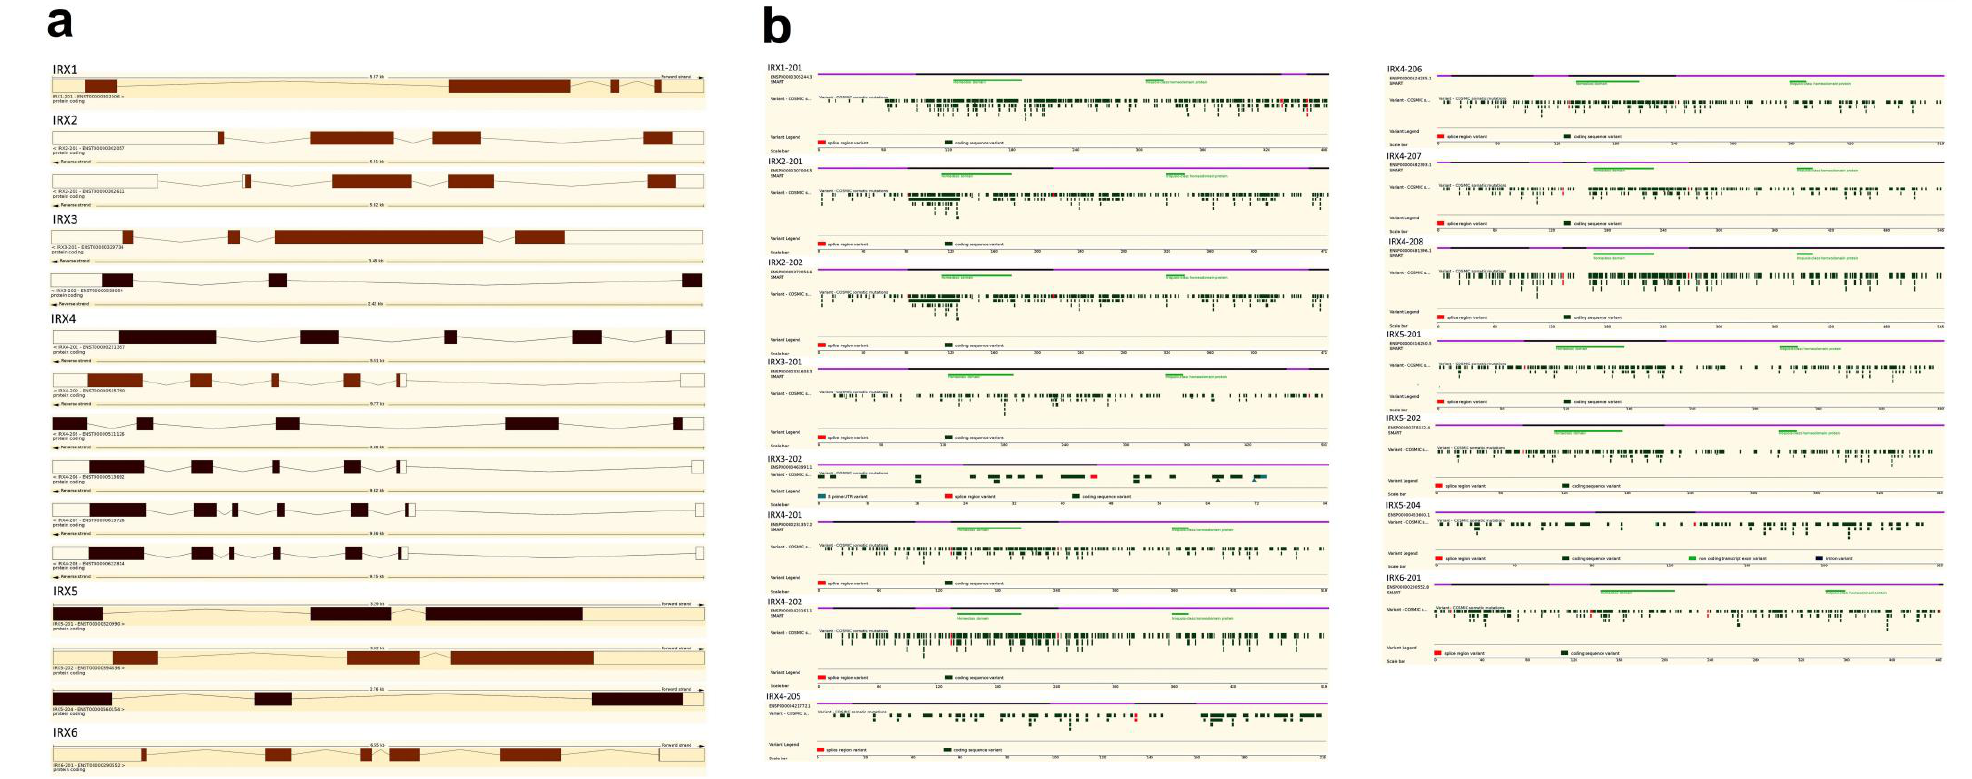
Figure 1. ( a ) Exon/intron structure of 15 transcripts encoding proteins of the Iroquois family. The figure shows representations of the transcript structures. The protein-coding exons are shown as colored rectangles, and introns are shown as lines. The figure information was retrieved from Ensembl (https://www.ensembl.org/index.html, Last accessed on 19 January 2023). A dark brown transcript comes from either the Ensembl automatic annotation pipeline or manual curation by the VEGA/Havana project. (https://vega.archive.ensembl.org/index.html, Last accessed on 19 January 2023). A light brown transcript is identical between Ensembl automated annotation and VEGA/Havana manual curation. ( b ) Protein structure of 15 Iroquois transcripts. Exons are colored as light and dark purple. Light green bars represent the domain location in the protein. The figure information was also retrieved from Ensembl.